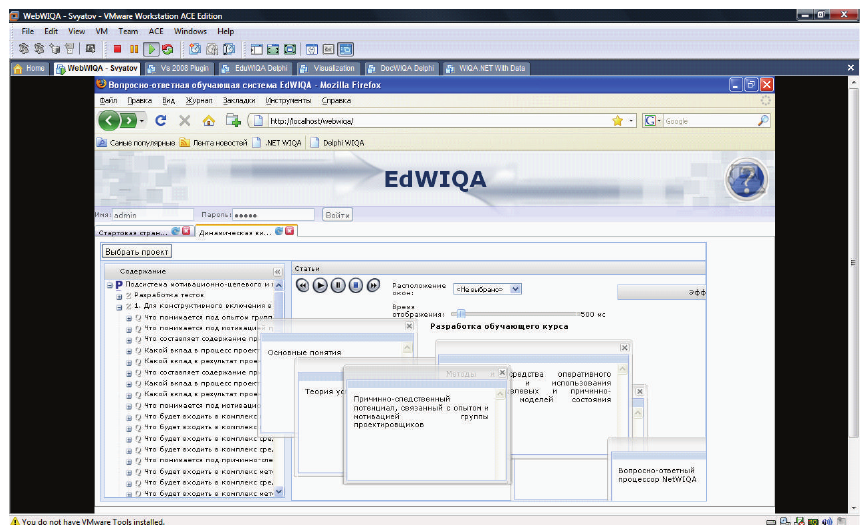
Figure 8: Web-view of visualization for QA-model.